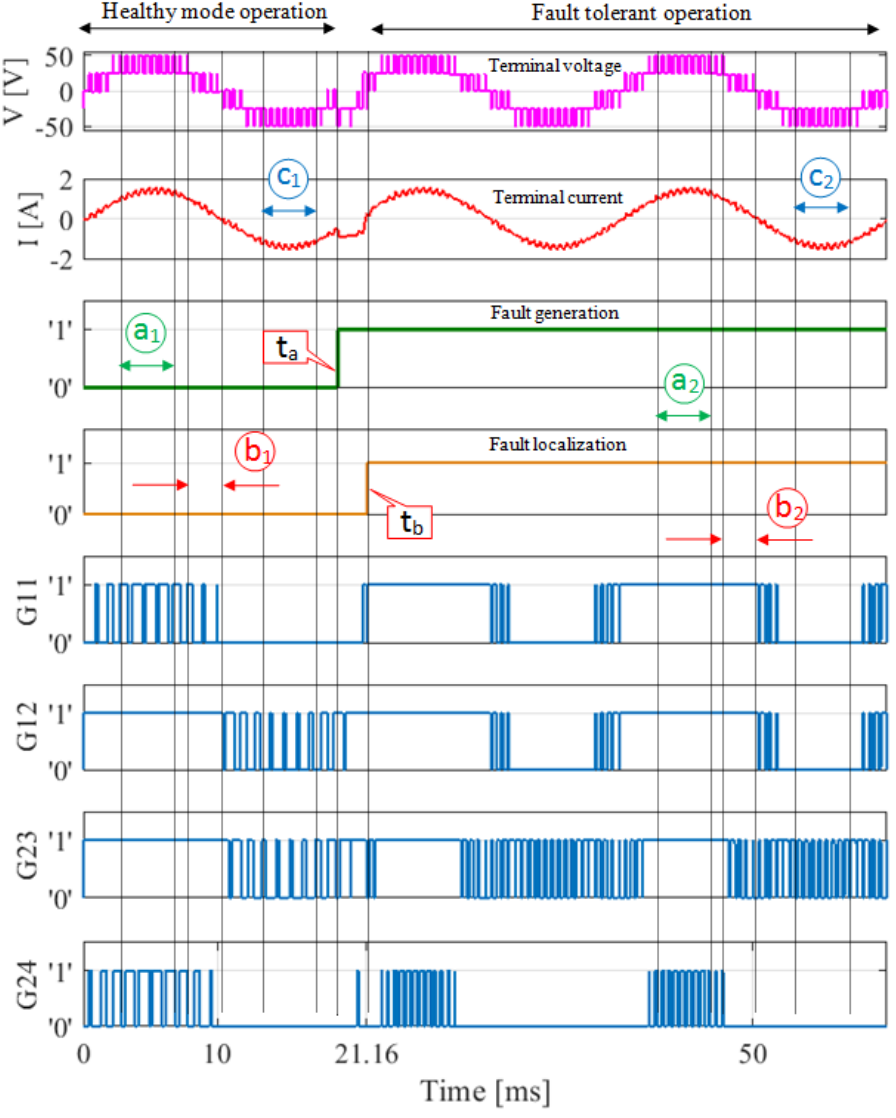
Figure 7. Simulation results for fault-tolerant operation of the inverter in the case of a short-circuit fault event in S14.